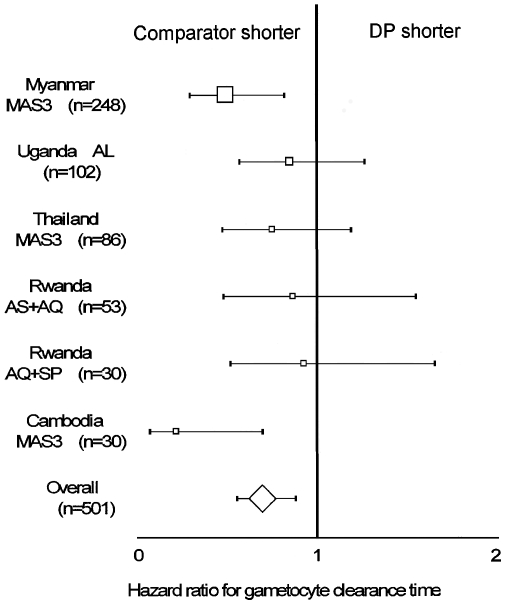
Note: the forest plot represents the risk of clearing gametocytes
comparing DP versus comparator drugs in randomised studies.The endpoint was assessed at Day 14. Overall result was stratified by
site. The size of boxes is proportional to the number of patients
included and thus to the overall effect. The diamond represents the
overall hazard ratio and 95% CI.